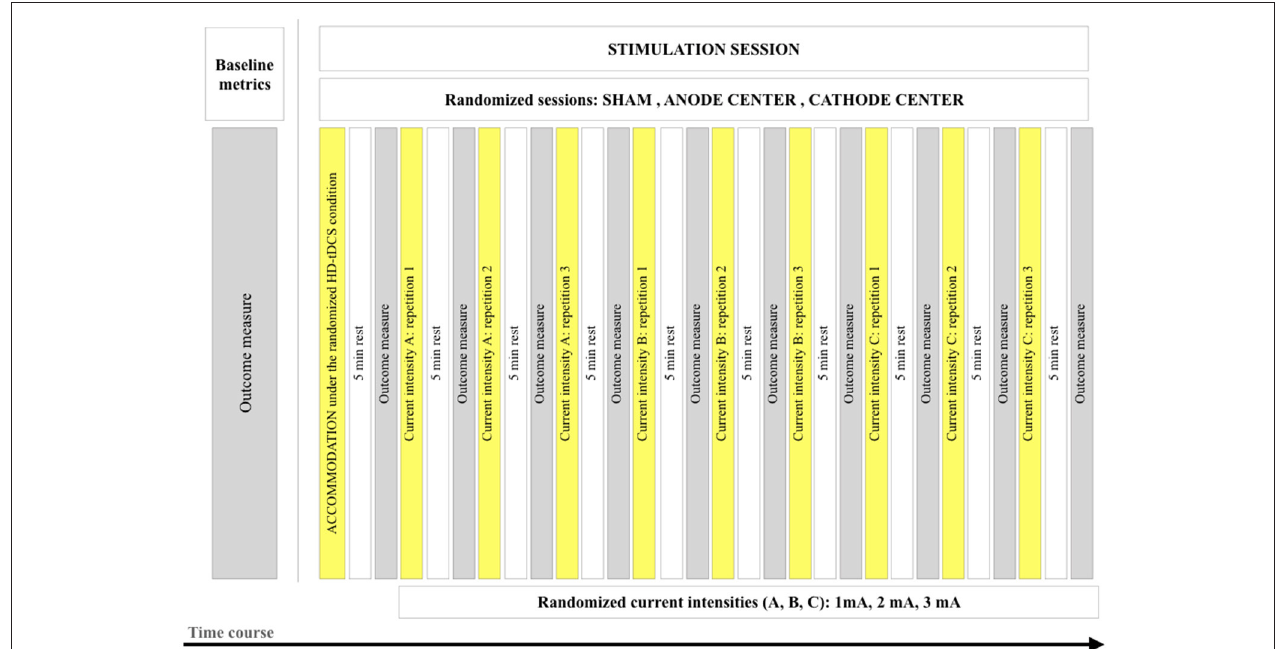
FIGURE 1 | Illustration of the stimulation protocol and time course of the study.